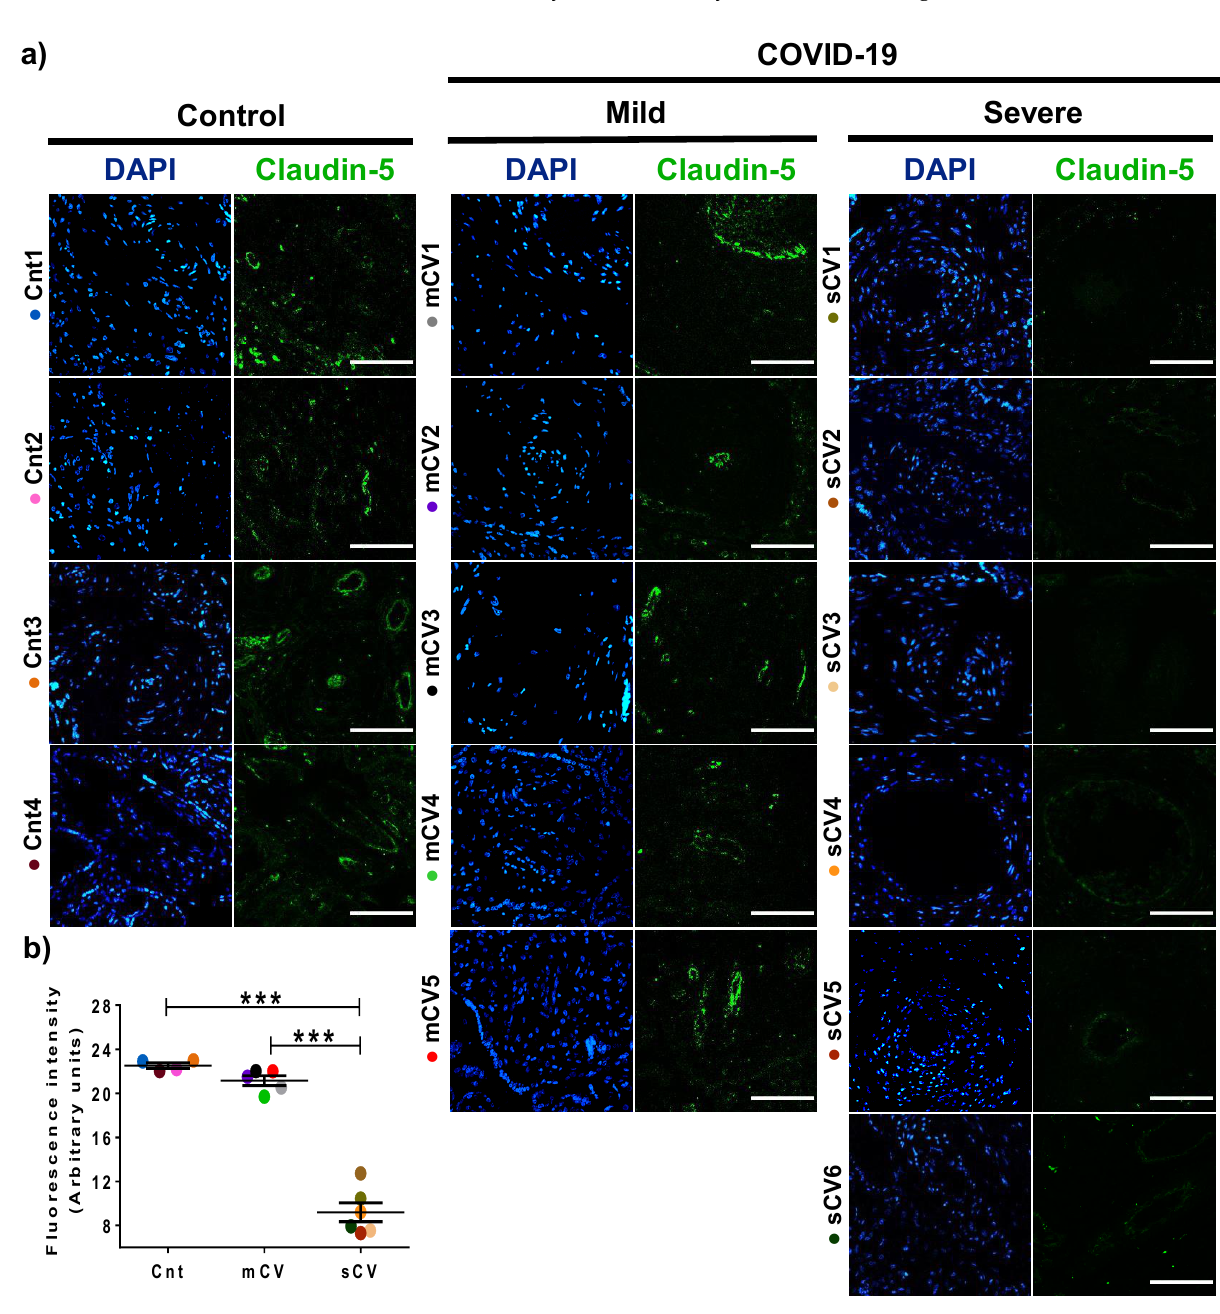
Figure 3. The expression of claudin-5 decreases in decidual endothelium of women with severe COVID-19. Paraffin blocks of placentas derived from women with COVID-19 and controls were cut in 1 µm slices, deparaffinized, and processed for immunofluorescence with antibodies against claudin-5. ( a ) Representative images of claudin-5 in decidua. DNA of nuclei was stained with DAPI. Bar, 100 μm. ( b ) Quantification of mean fluorescent intensity done on three independent images from each condition. Data are expressed as mean ± SD; F test with Welch correction followed by the multiple comparison tests of Bonferroni and Dunnett, *** p < 0.001. Cnt, control; mCV, mild COVID-19; sCV, severe COVID-19.